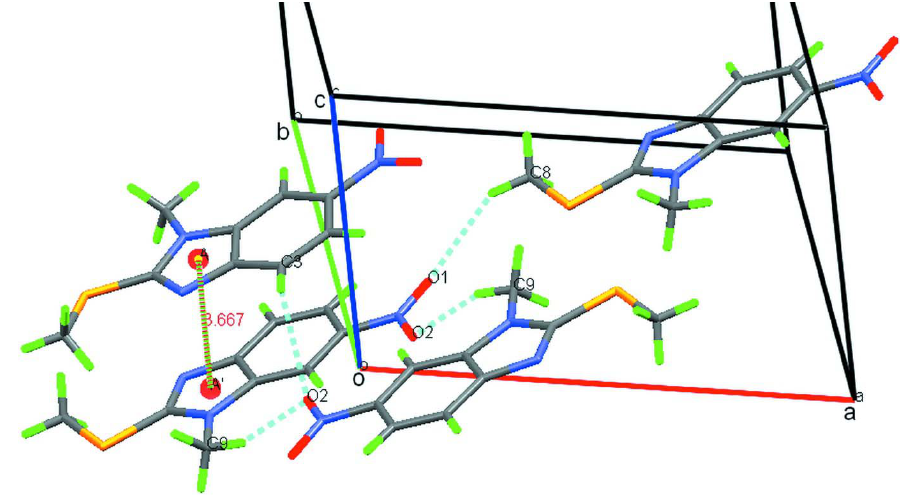
Plot of the molecule of the title compound with the atom-labelling scheme. Displacement ellipsoids are drawn at the 50% probability level. H atoms are represented as small circles.